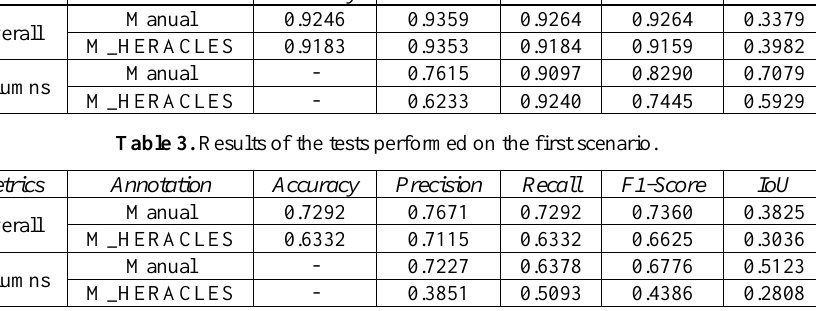
Table 4. Results of the tests performed on the second